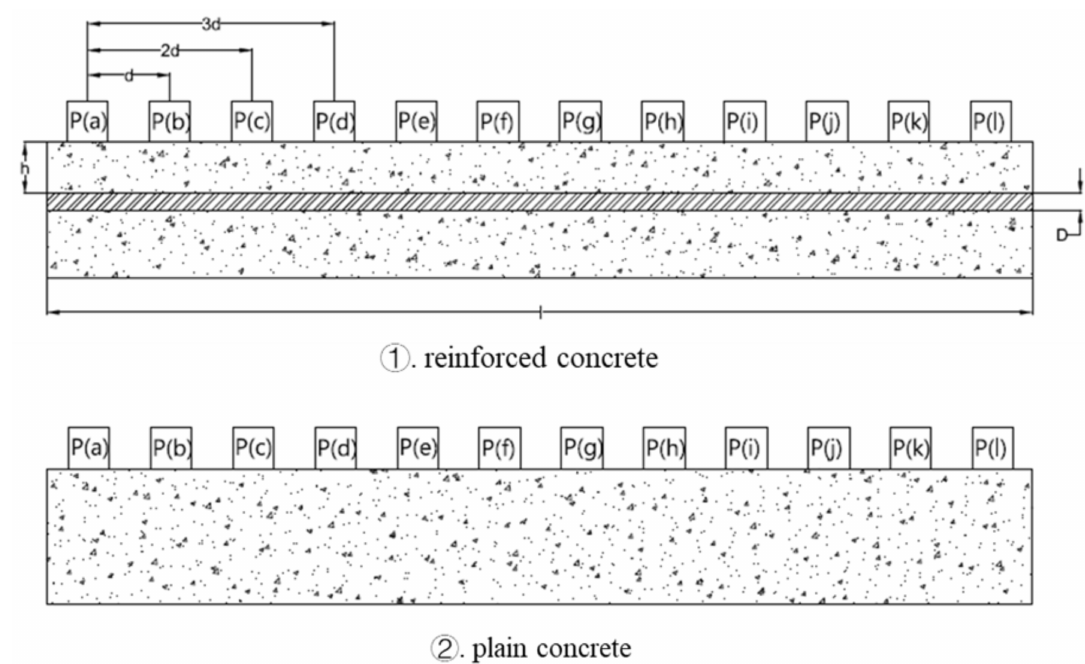
Figure 3. The arrangement of transducers.